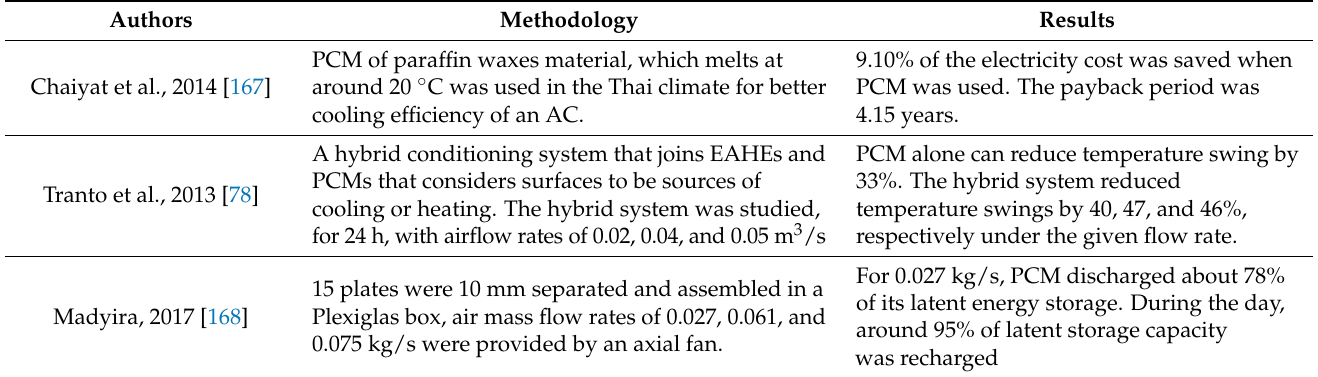
Table 8. Summary of the investigated papers related to PCM effect on HVAC systems.